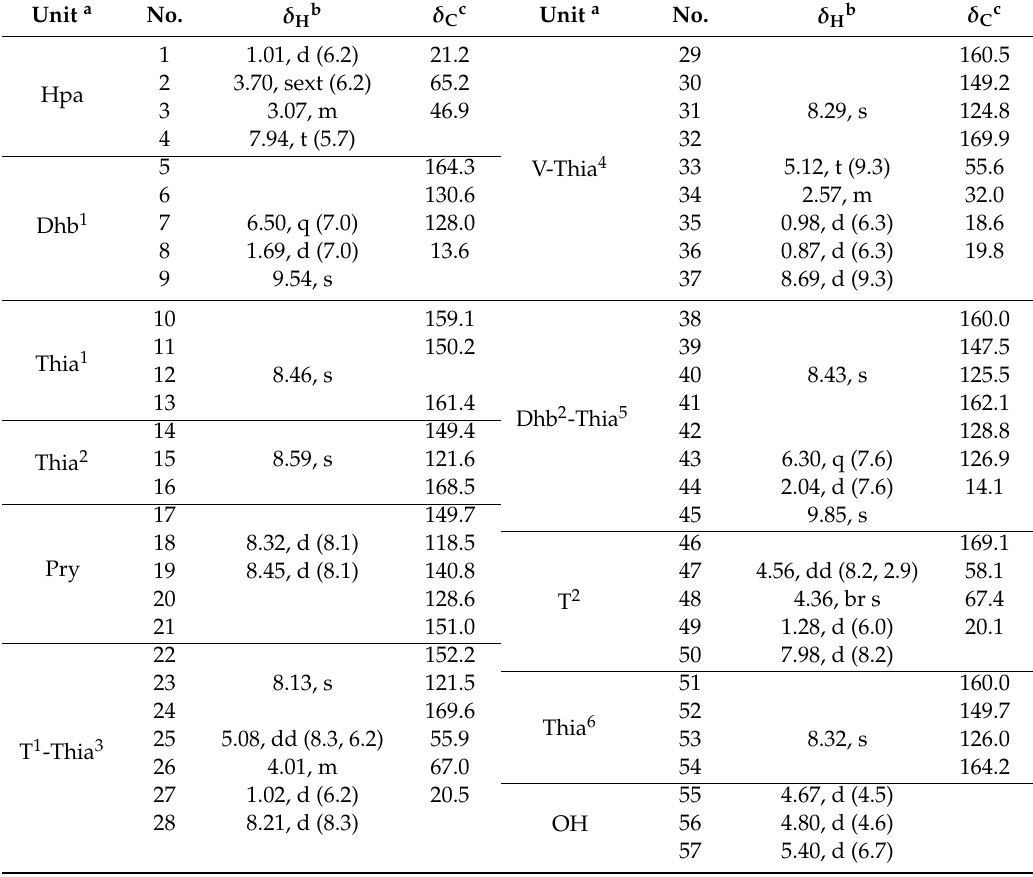
Table 1. 1 H (700 MHz) and 13 C (175 MHz) NMR data of compound 1 in DMSO- d 6